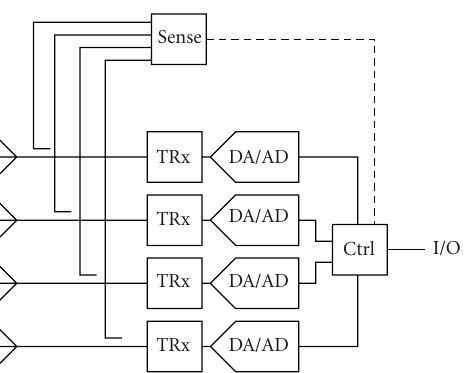
Figure 2: A simplified block schematic diagram of a typical array calibration